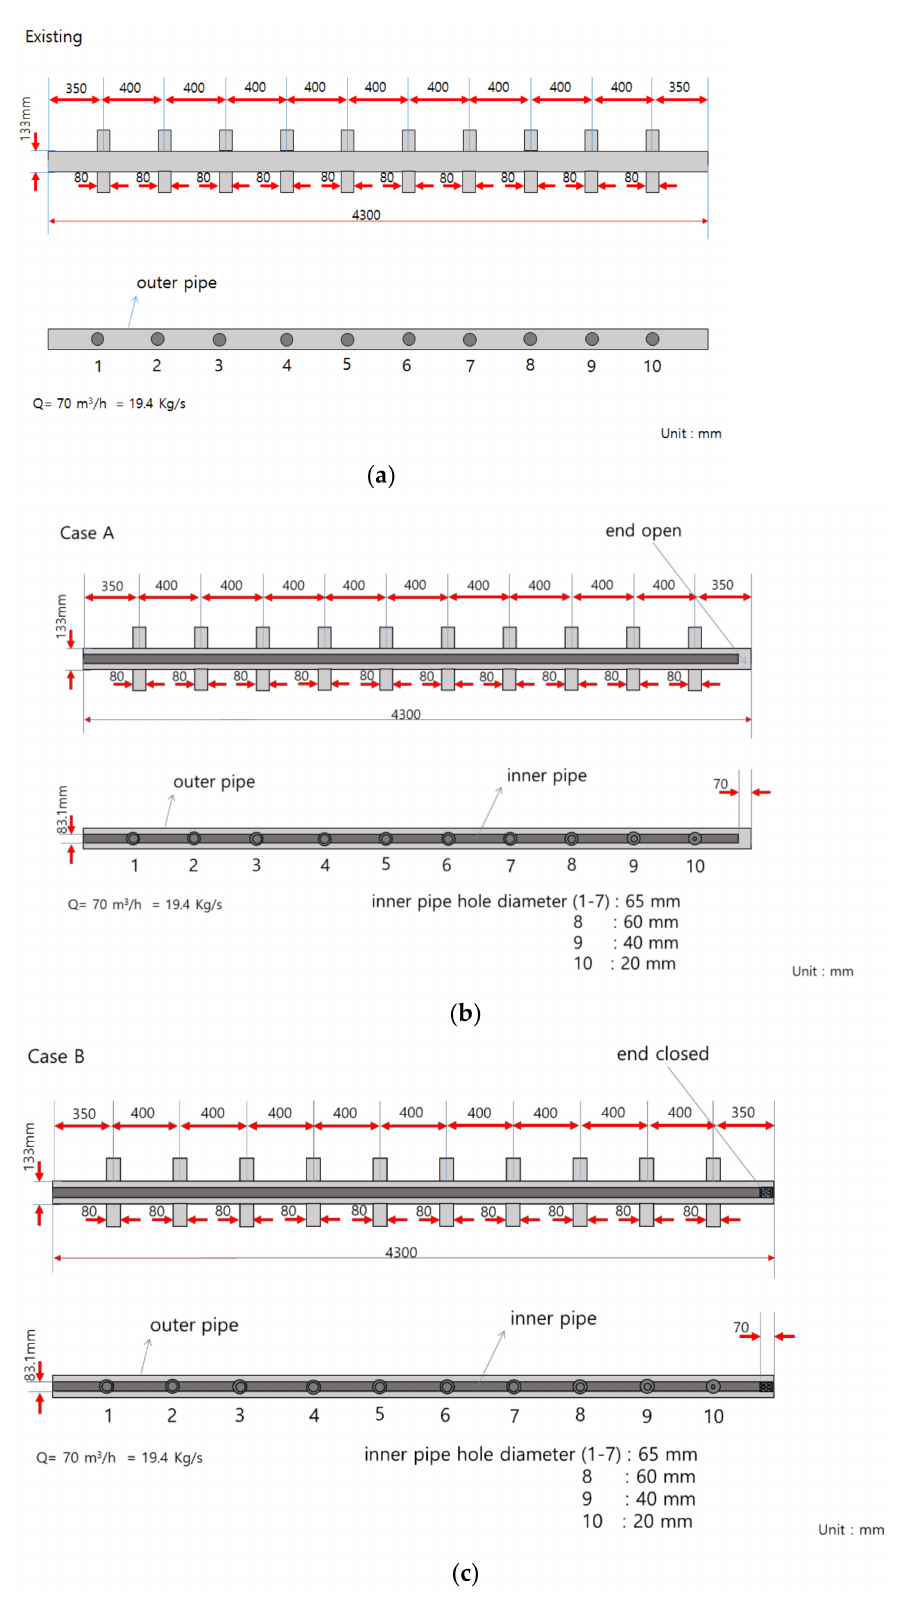
Figure 3. Geometry of inlet header manifold pipes: ( a ) existing pipe (single-manifold pipe); ( b ) double-manifold pipe (Case A, end open); ( c ) double-manifold pipe (Case B, end